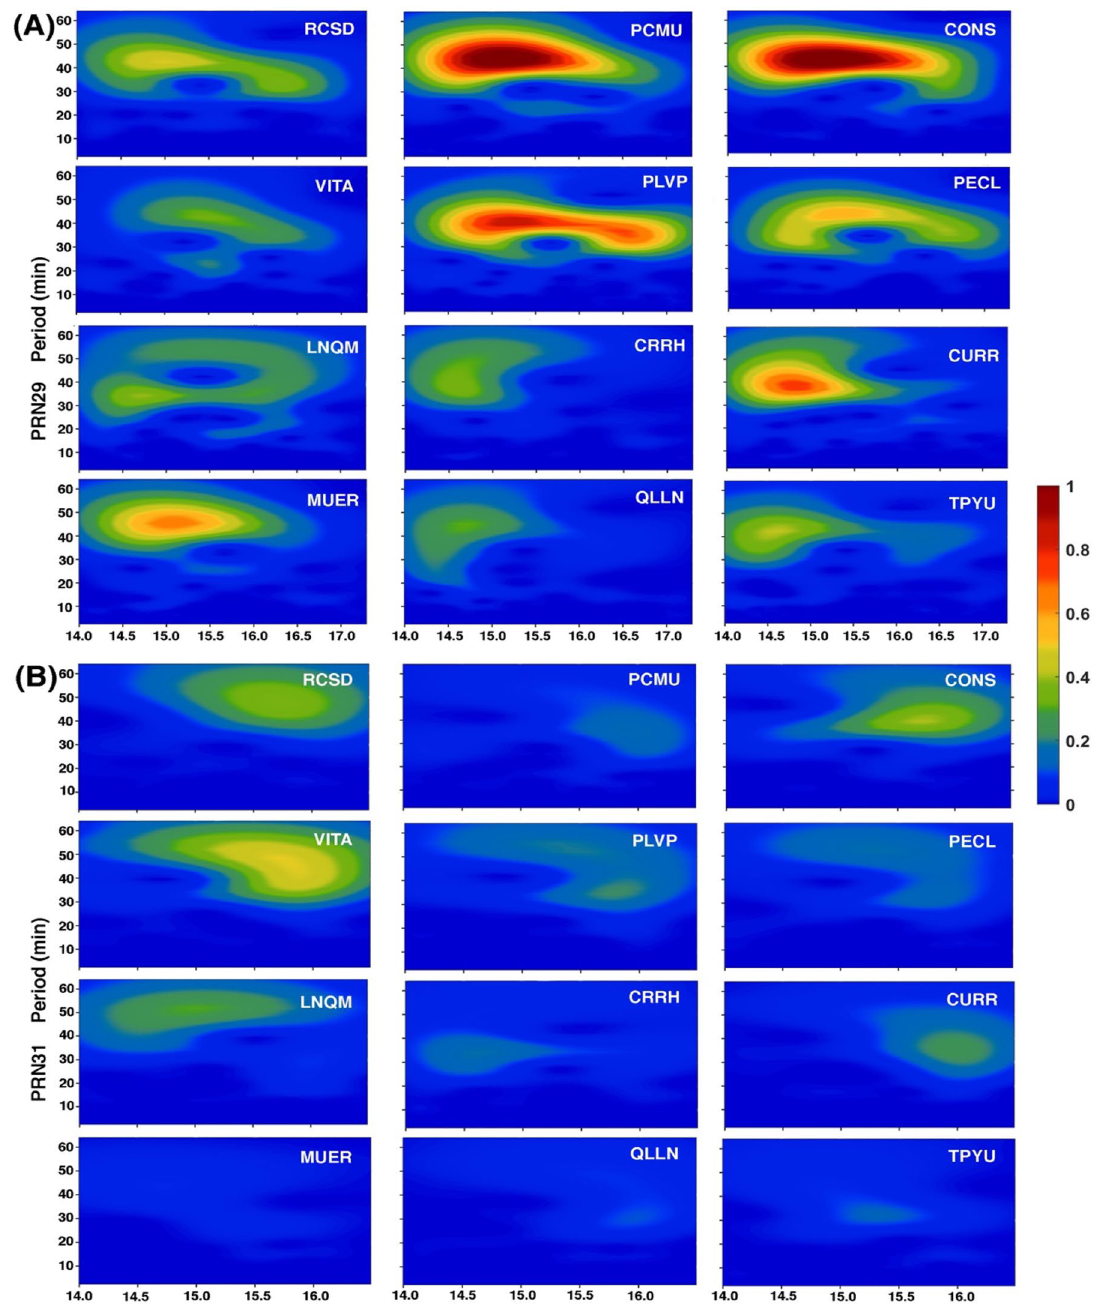
Figure 4. Wavelet analysis of VTEC time series of PRN 29 and PRN31 using Morlet mother wavelet, show atmospheric gravity waves with period ~ 30–60 min are present during eclipse. Six representative GPS sites are shown. ( A ) The wavelet analysis of PRN29 of randomly chosen GPS sites VTEC time series. ( B ) The wavelet analysis of PRN31 of randomly chosen GPS sites VTEC time series. The Figure is prepared using the GMT 5.4.5 37